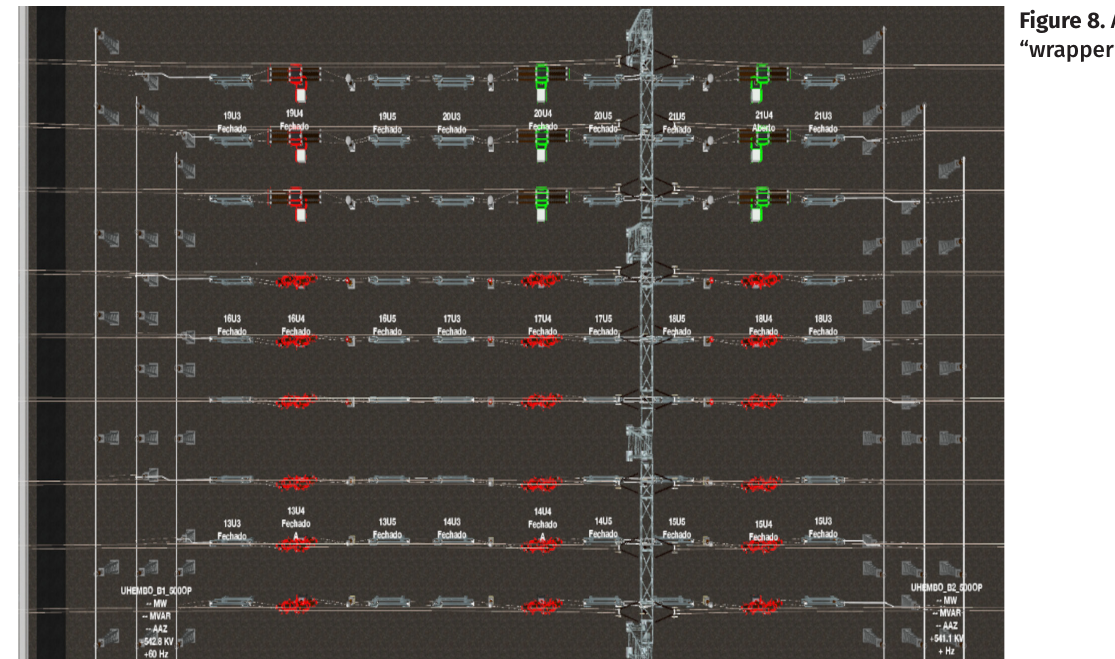
Figure 8. Active “wrapper”